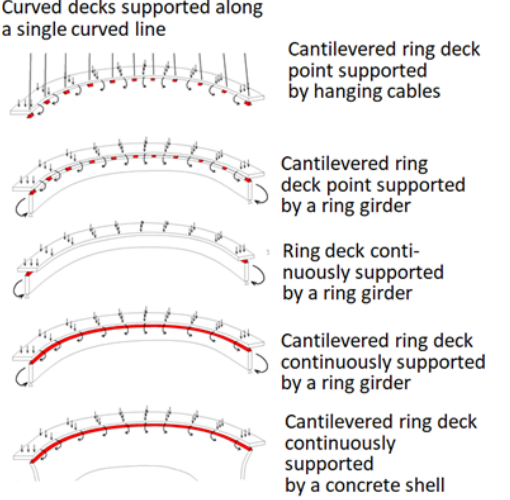
Figure 10: Curved cantilevered deck supported along a single curved line